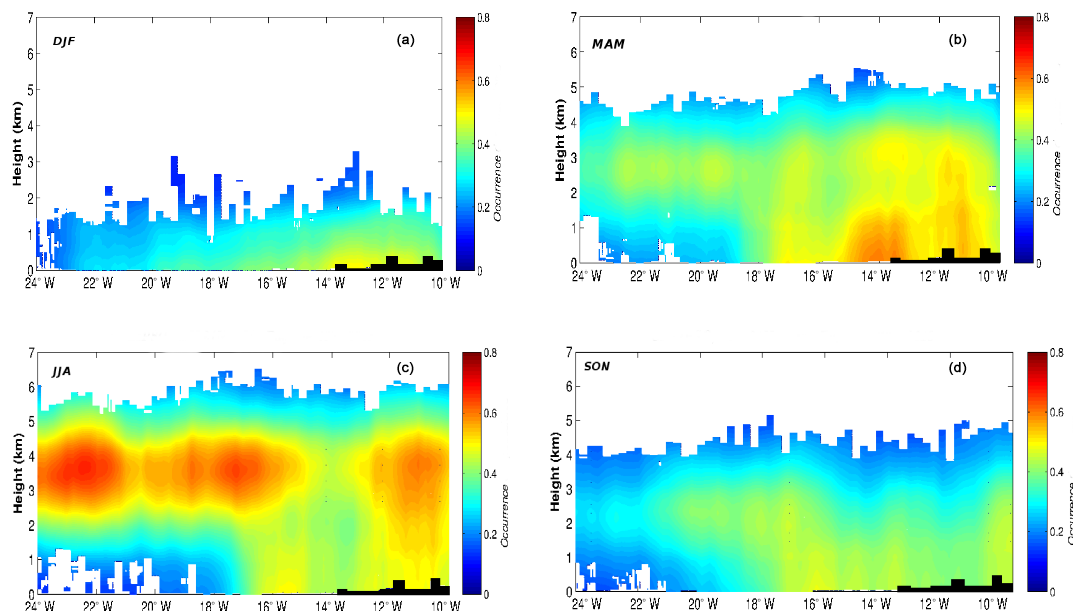
Figure 5. CALIOP daytime seasonal vertical distribution of the frequency of mineral dust aerosol occurrence zonally averaged between 12 and 21 ◦ N over the period 2007–2013: (a) DJF; (b) MAM; (c) JJA; and (d)